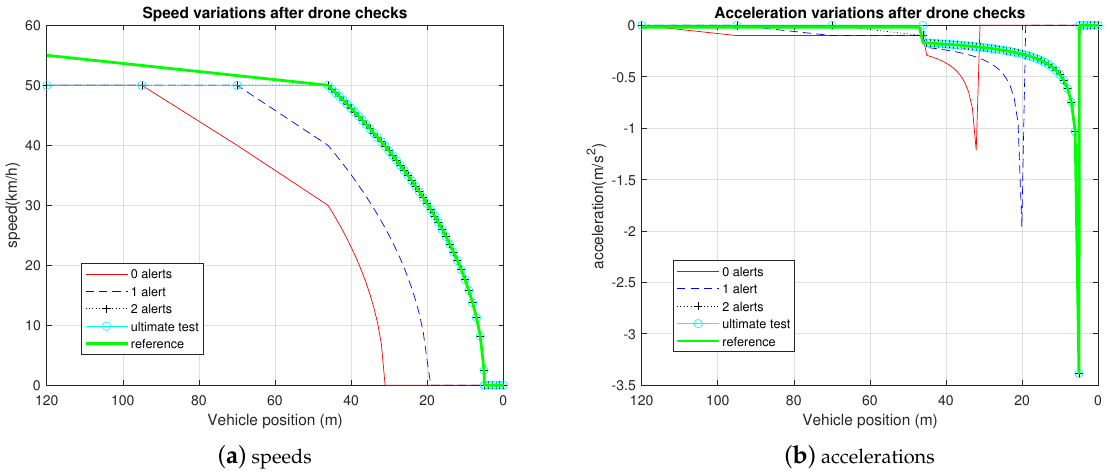
Figure 8. Speeds and accelerations of driver type 1, case of wet straight line.